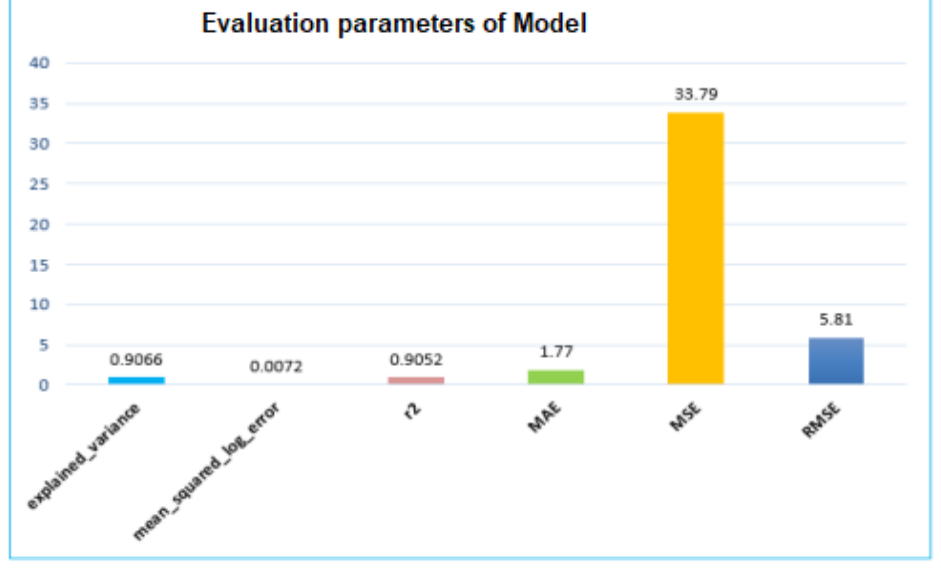
Figure 14. DT Performance.